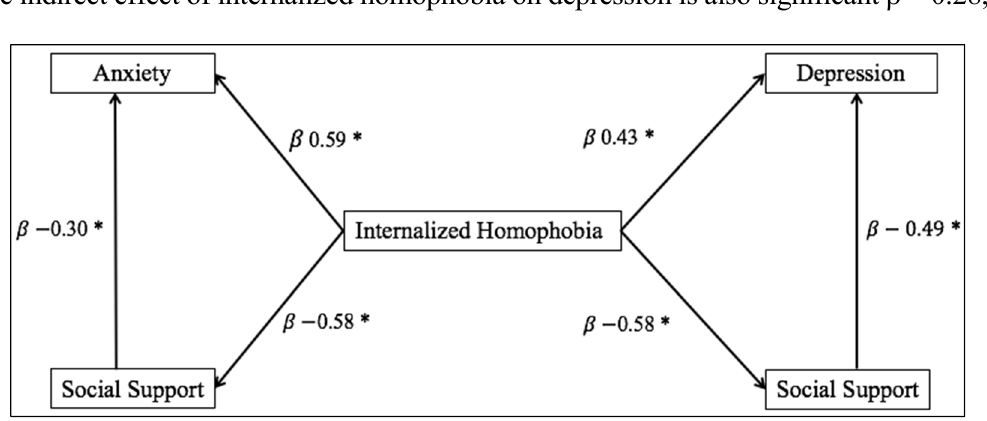
Figure 1. Path Analysis Model of relation between Internalized Homophobia variables, Anxiety, Depression, and Social Support among the male Italian sample, * p < 0.05